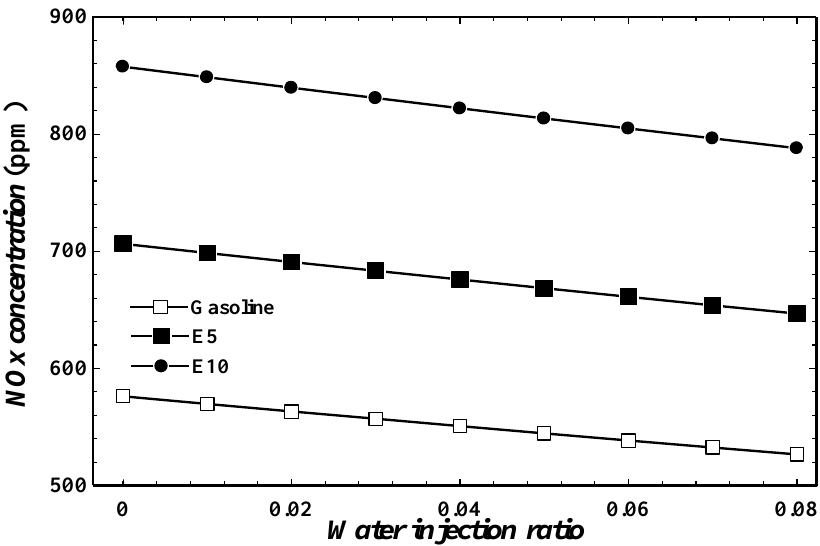
Figure 12. NOx concentration in various water injection ratios for each fuel.